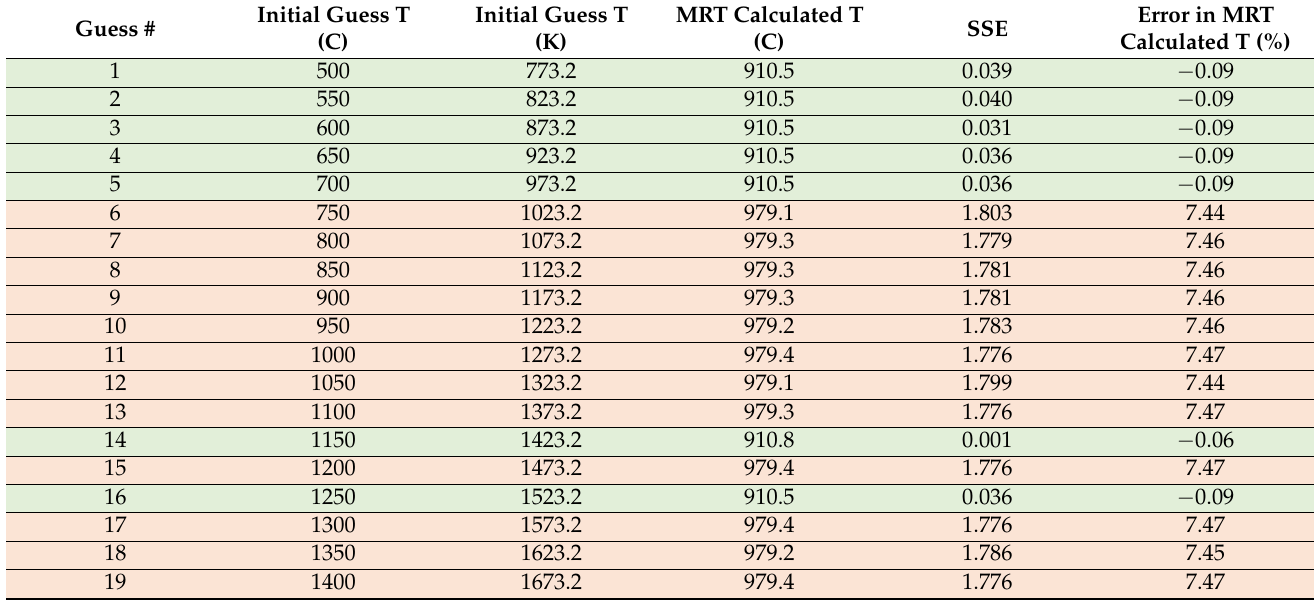
Table 4. MRT-calculated temperature, SSE values, and corresponding error in calculated temperature using 19 different initial guesses for temperature, based on pyrometry measurements of a 911.3 ◦ C (1184 K) surface, as described in Section 7. The colors are to highlight Guess # leading to solutions with low (green) or high (red)